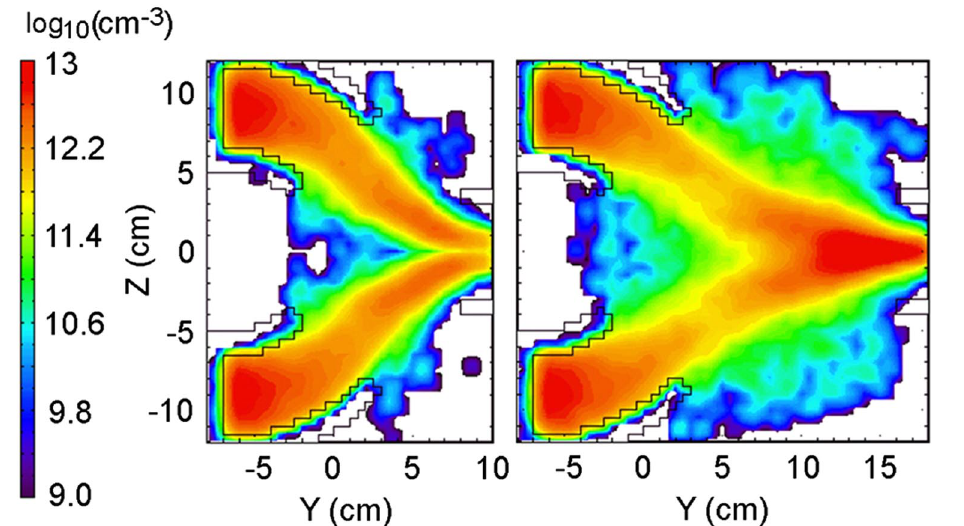
FIG. 16. (Color) f y; z g isocontours of n (cid:6) 53 kG final-focus solenoid, with a separation distance d (cid:6) 8 cm (left) and d (cid:6) 16 cm (right). The d (cid:6) 16 cm case is similar to B z the configuration planned for future experiments.